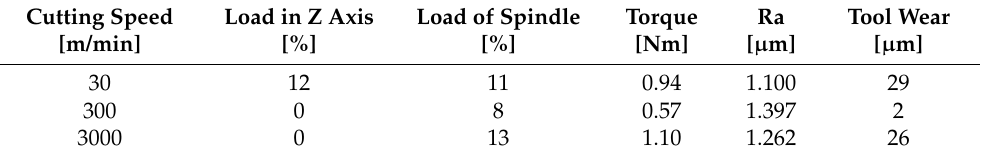
Table 10. Influence of cutting speed on significant observed parameters during machining of